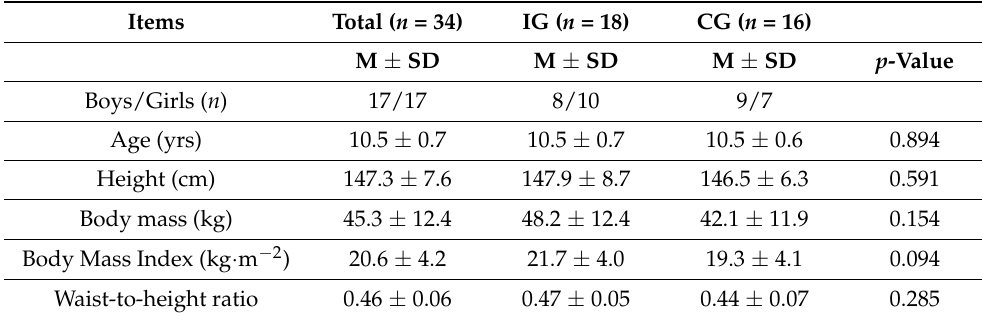
Table 1. Student’s characteristics at baseline.